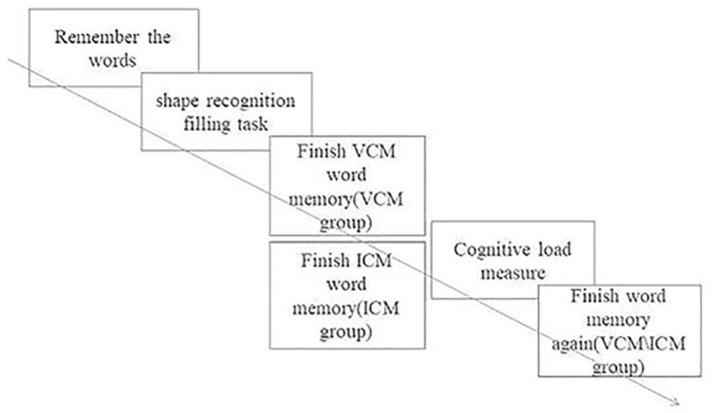
Trial of Experiment 2.